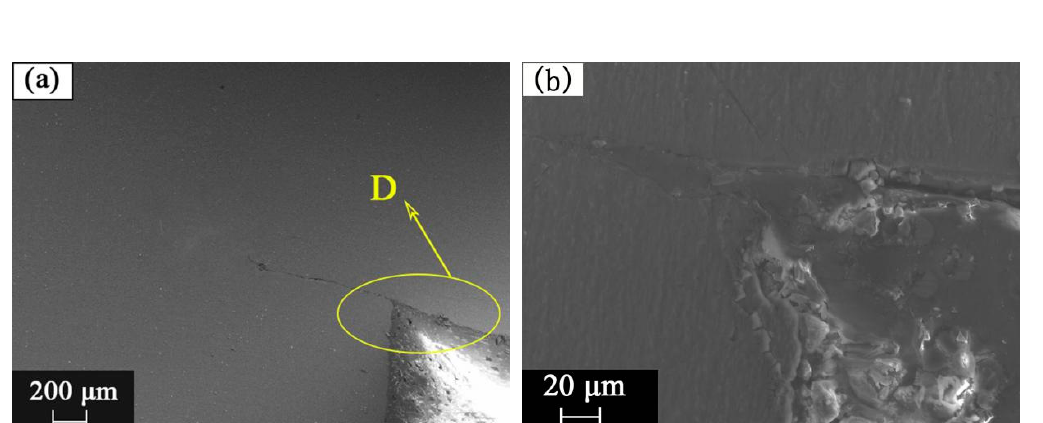
Figure 8. The SEM images of ( a ) A region in Figure 5a and ( b ) D region.